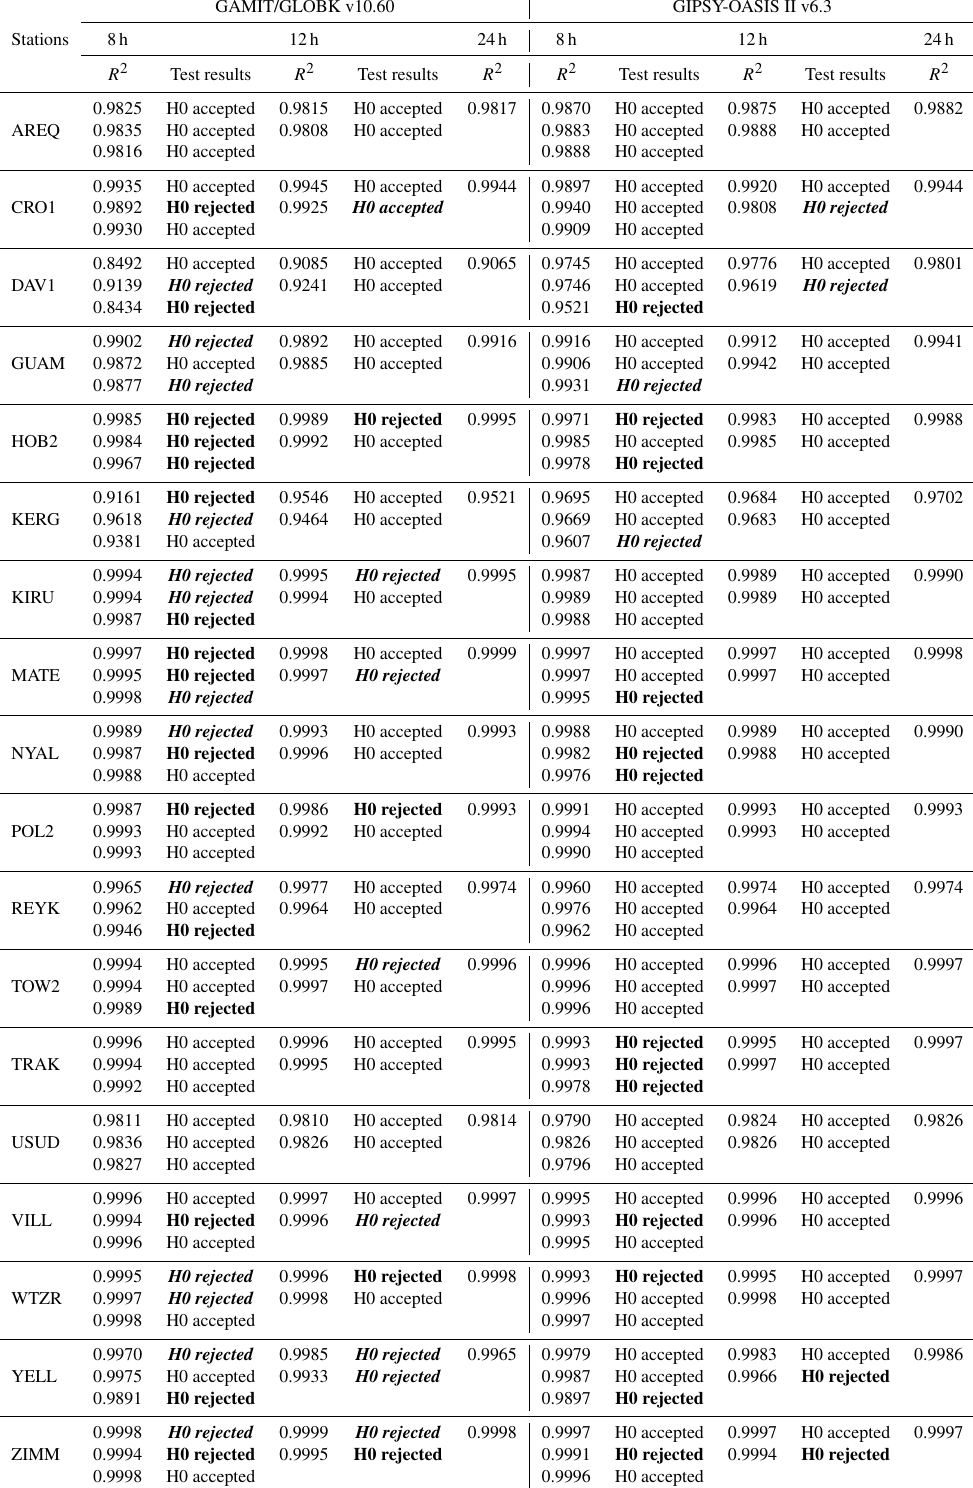
Table 4. For the east component, R 2 values and hypothesis test results for relative positioning and PPP. GAMIT/GLOBK